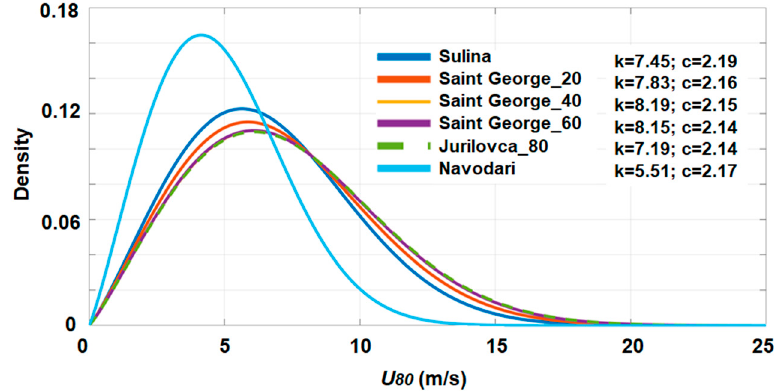
Figure 5. Weibull PDF distributions indicated for some reference sites, considering ERA-Interim data reported for the time interval from January 1998 to December 2017.